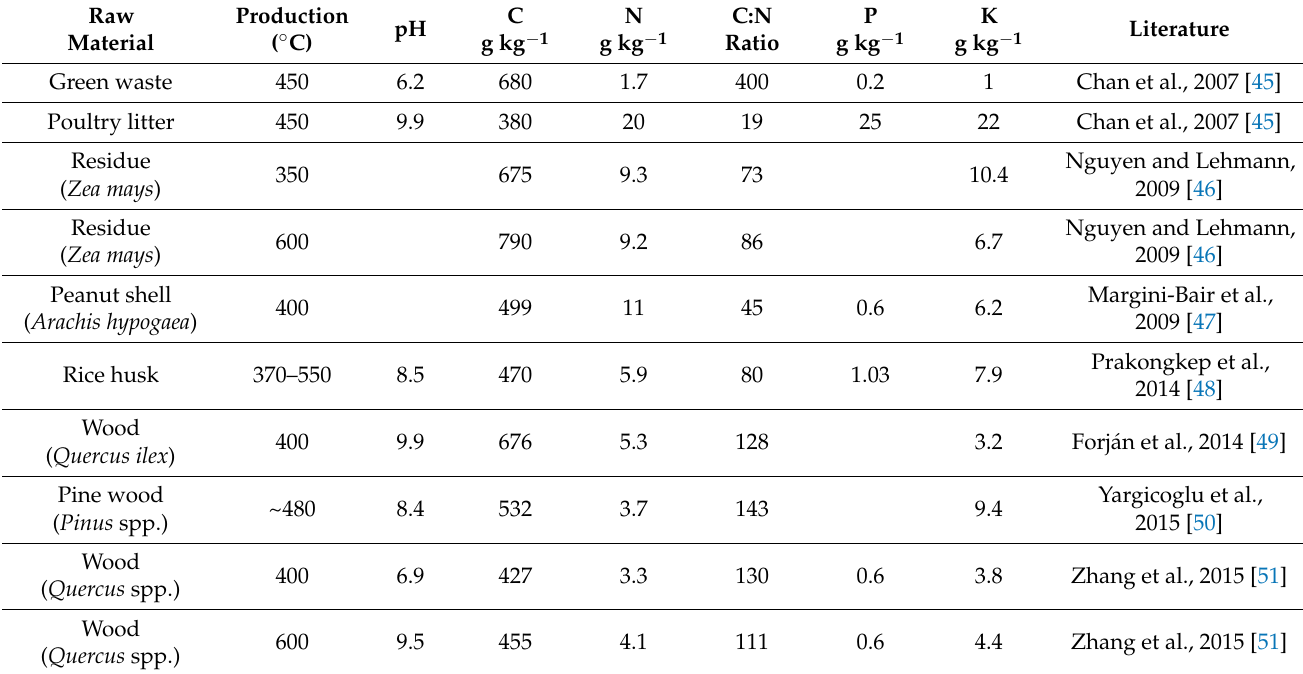
Table 3. Chemical constituents of biochar produced from various feedstock sources under different production temperatures (based on Jatav et al., 2021